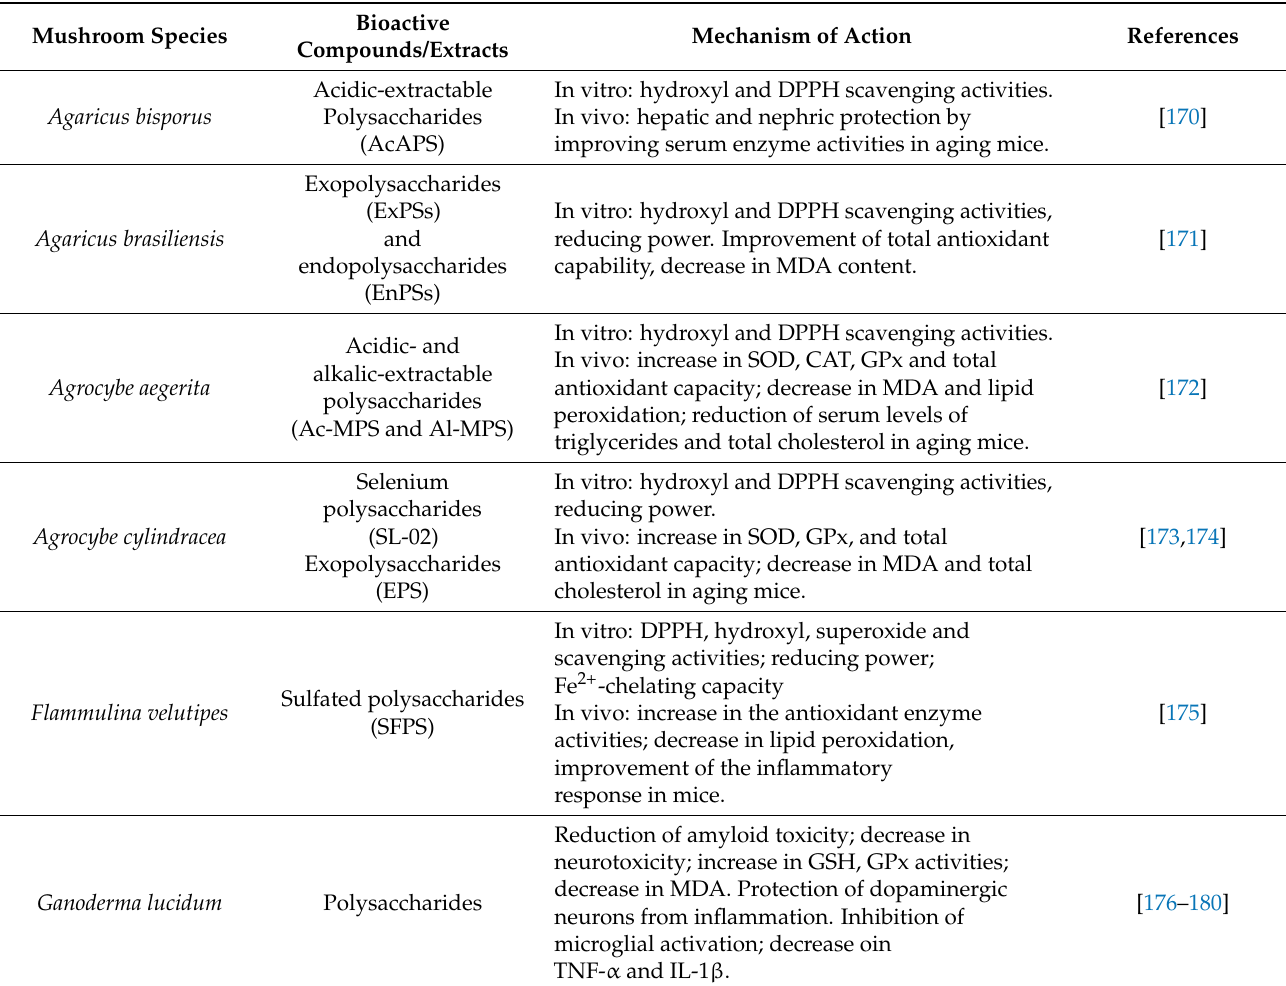
Figure 7. The supplementation of mushroom antioxidants to counteract the ROS/RNS in aging. Table 1. Antioxidant polysaccharides from edible mushrooms with anti-aging